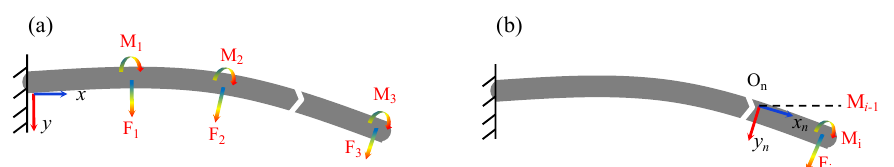
Figure 2. ( a ) The mechanical model of the equivalent beam. ( b ) The mechanism of reconstruction process of different